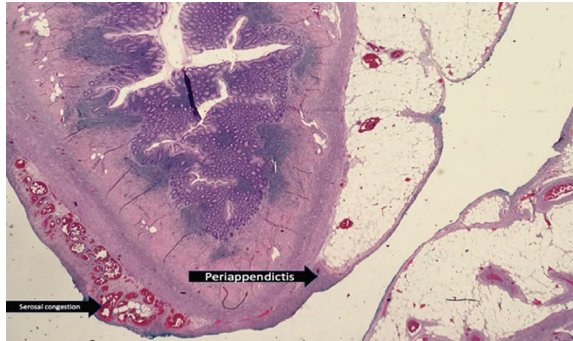
Figure 6: Serosal congestion and